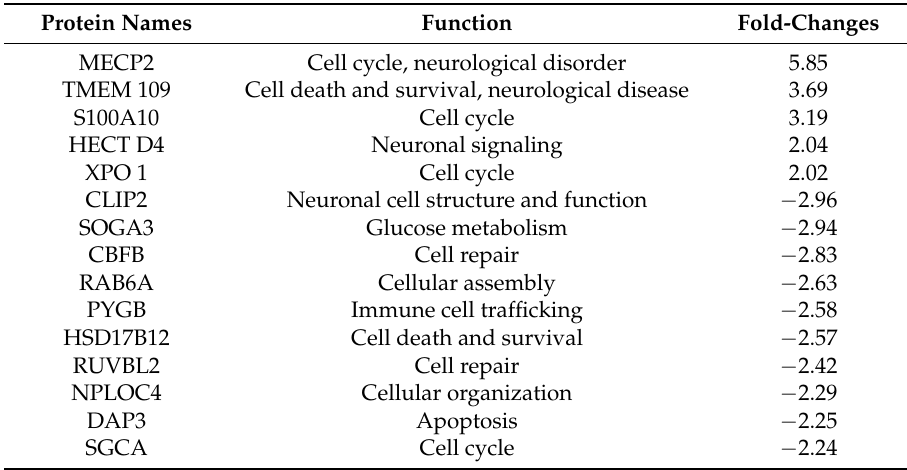
Table 2. Differentially expressed proteins identified by IPA in the mouse retina in response to µ g + 1 g vs. habitat control (fold change >2; FDR corrected p < 0.05).